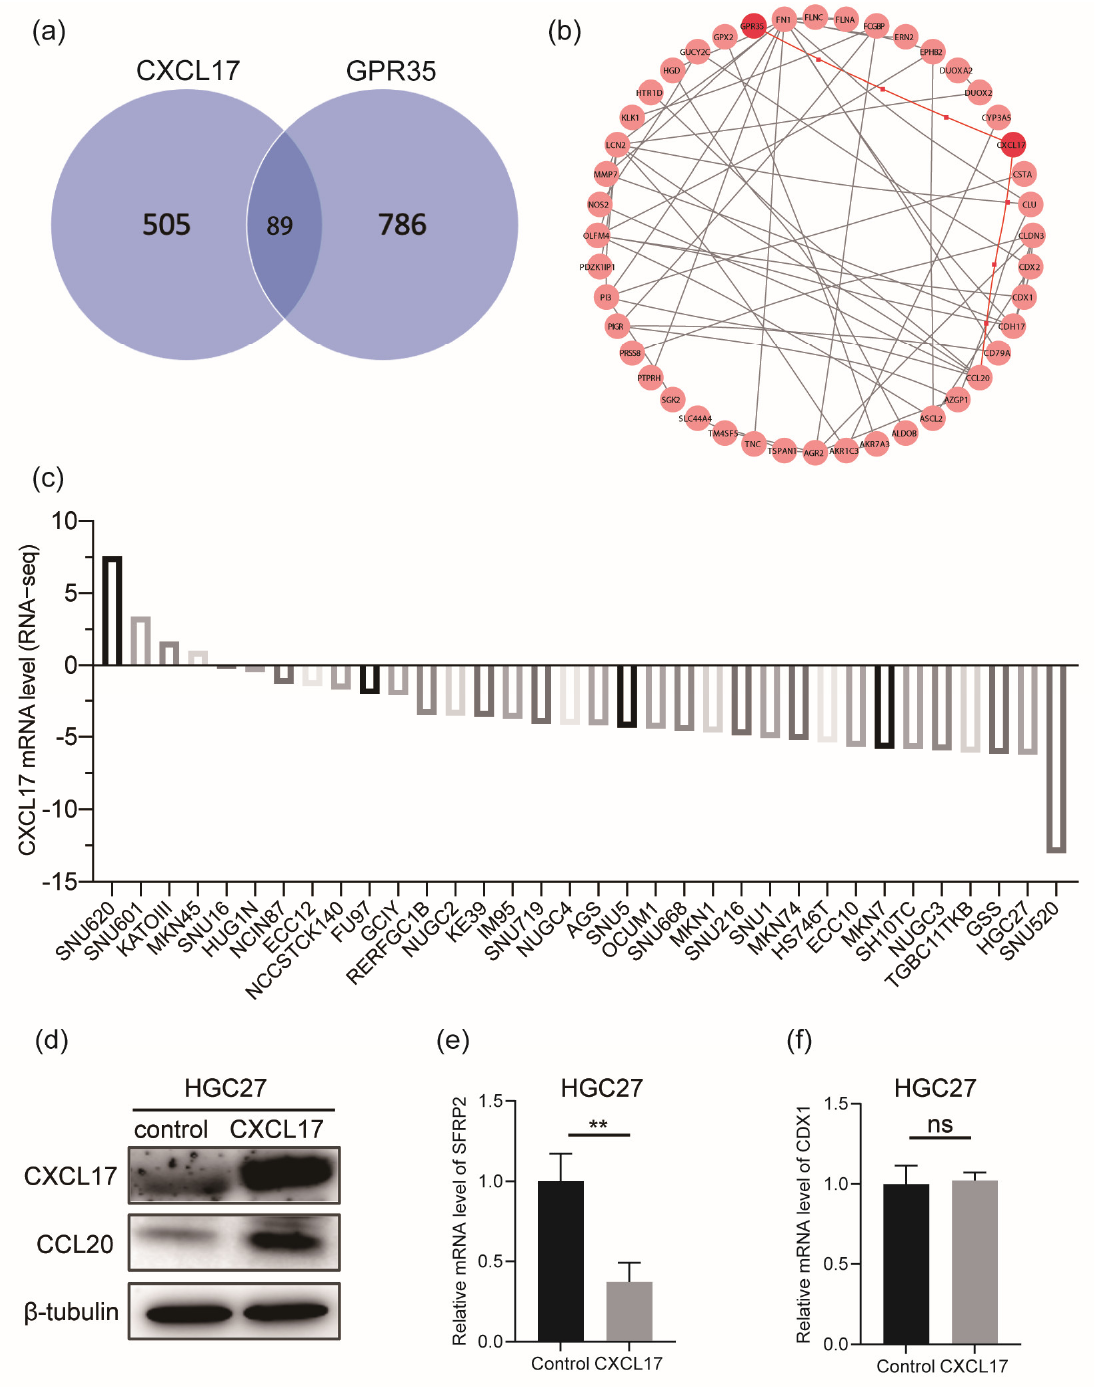
Figure 6. Overexpression of CXCL17 upregulated CCL20 expression. Eighty-nine DEGs ( a ) shared by CXCL17 and GPR35 were used for PPI analysis ( b ). CXCL17 mRNA level in the CCLE cell lines ( c ). The protein level of CCL20 was significantly upregulated after transfecting a CXCL17 overexpression plasmid into the HGC27 cells ( d ). The mRNA level of SFRP2 ( e ) was downregulated upon the overexpression of CXLC17, while the CDX1 level ( f ) remained unchanged. ** p < 0.01. ns, no significance; PPI, protein–protein interaction; CCLE, Cancer Cell Line Encyclopedia.